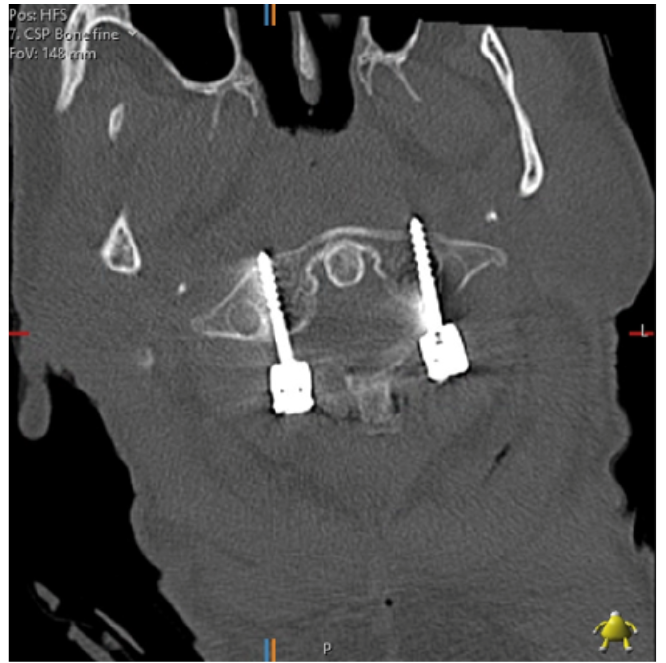
Figure 1. C1/2 fixation performed under fluoroscopic guidance; the left foramen transversarium has been penetrated by a pedicle screw. The patient suffered a massive posterior stroke and died within 24 h.